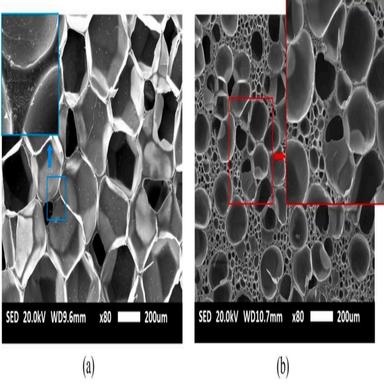
The microstructures of PMI foam materials with different densities, (a) PMI foam with density of 0.075 g/cm3 ; and (b) PMI foam with density of 0.205 g/ cm3 . For PMI foam with density of 0.075 g/cm3 , the size and distribution of cells are quite uniform. However, the PMI foam material with density of 0.205 g/cm3 exhibits a hierarchical microstructure.